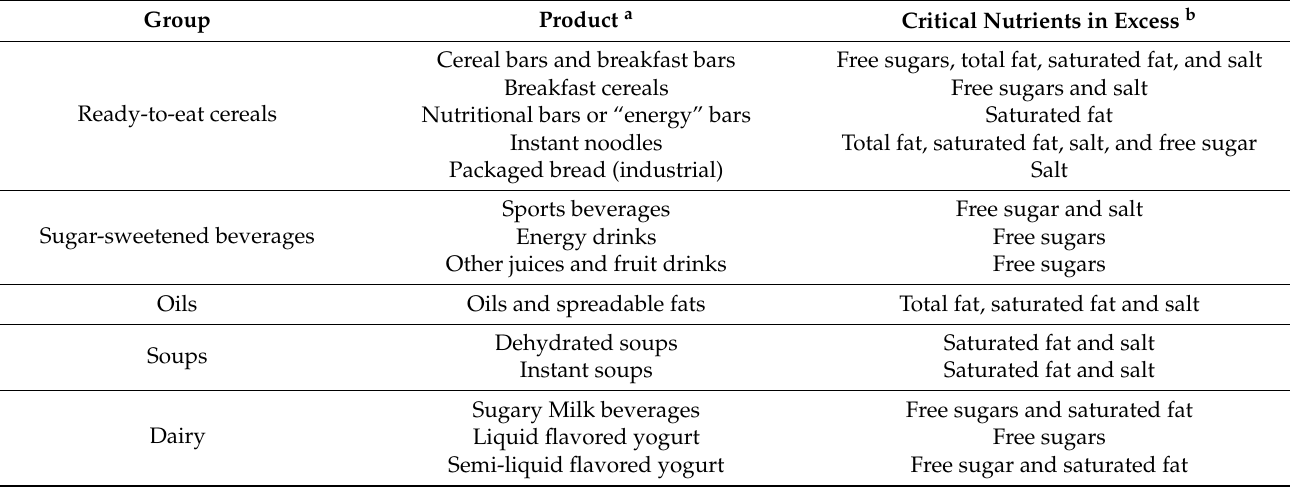
Table 2. Ultraprocessed products with added micronutrients and their nutritional profiles, commonly sold in Latin American